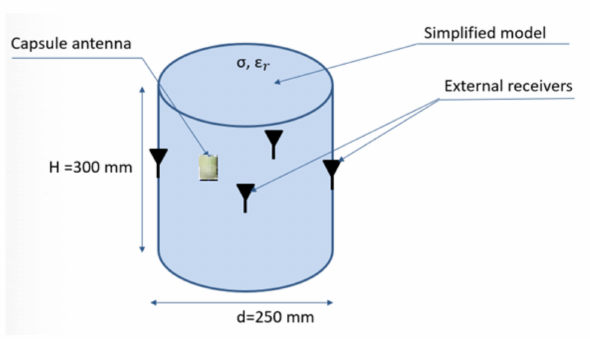
Figure 12. Simplified model and external antennas configuration used during